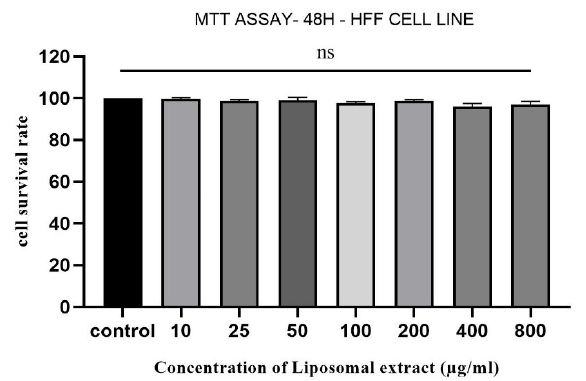
Figure 10. Obtained Results From MTT, Treatment of HFF Cells With Different Concentrations of Liposomes Containing Extracts After 48 Hours. Note. ns: No siginicant difference; MTT: 3- [4, 5-dimethylthiazol-2-yl]-2, 5-diphenyl-tetrazolium bromide; HFF: Human foreskin